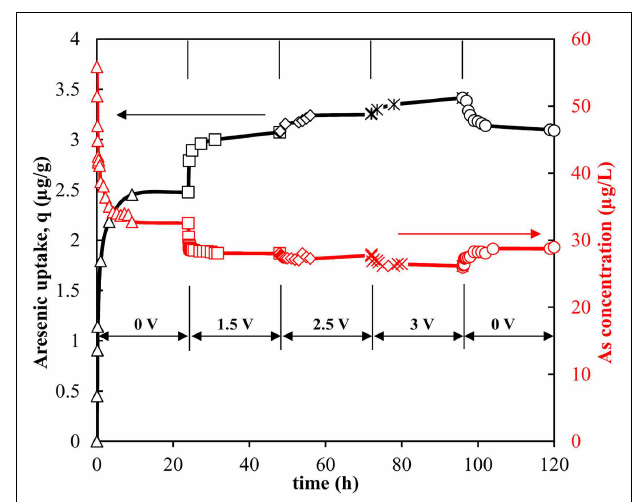
FIGURE 5 |Arsenic uptake (black line) and remaining concentration (red line) as a function of time during the adsorption and electroadsorption experiment in cathodic treatment (GAC on the cathode compartment) .Voltage was varied sequentially during the experiment as follows: (i) normal adsorption in absence of current (triangle); (ii) electroadsorption at 1.5V (square); (iii) electroadsorption at 2.5V (diamond) (iv) electroadsorption at 3.0V (asterisk); (v) arsenic desorption in absence of current